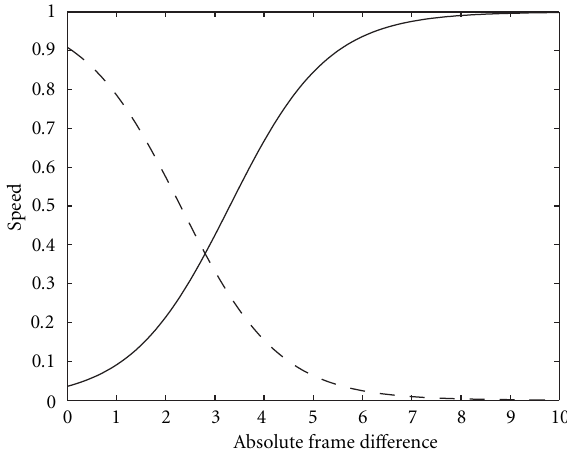
Figure 4: The propagation speeds of the two labels; solid line: “changed” label, dashed line: “unchanged”